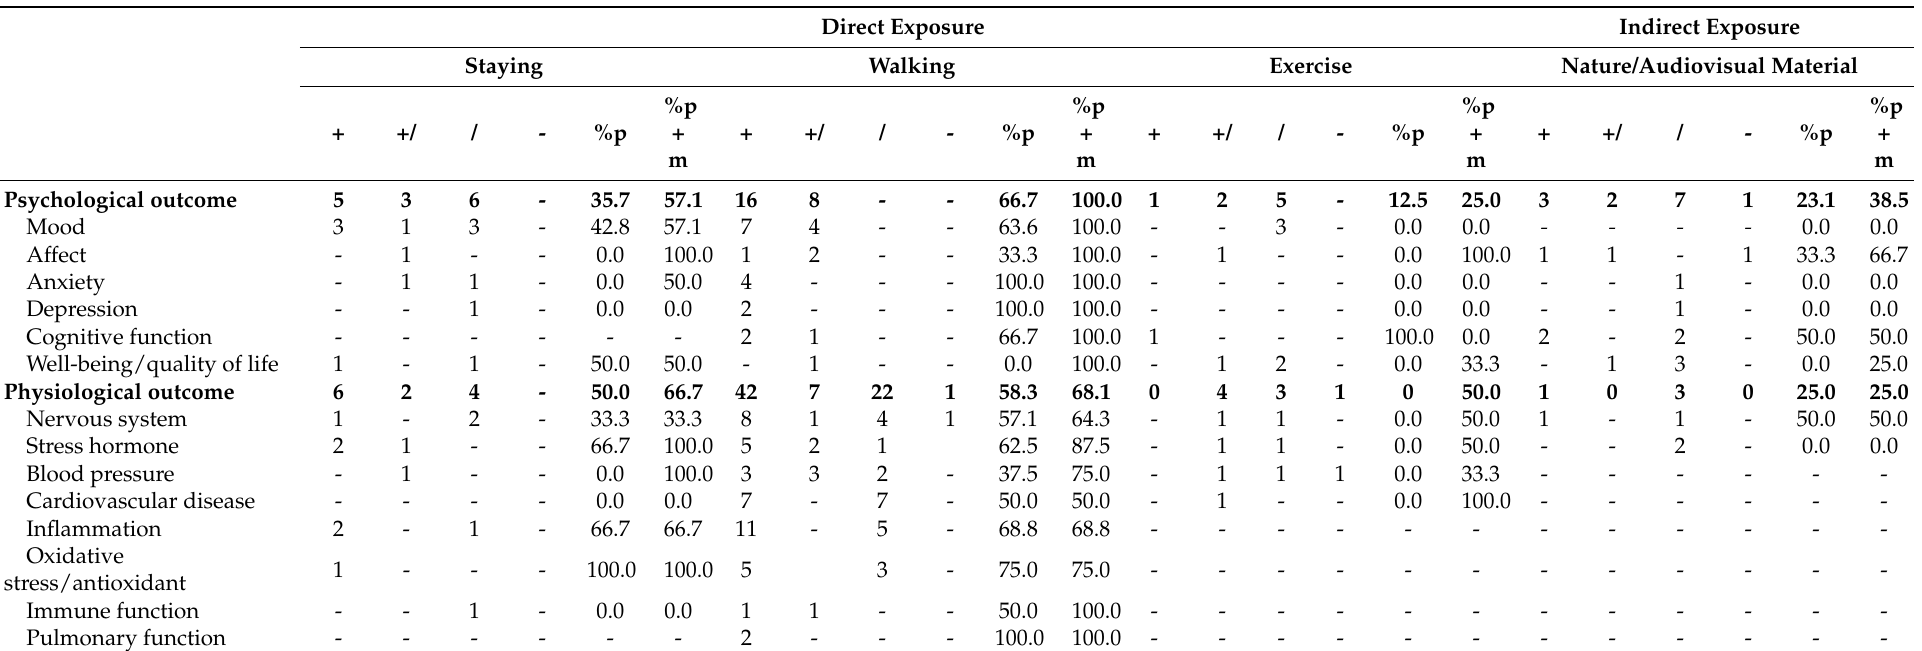
Table 4. Psychological and physiological outcomes according to the activities conducted in the included